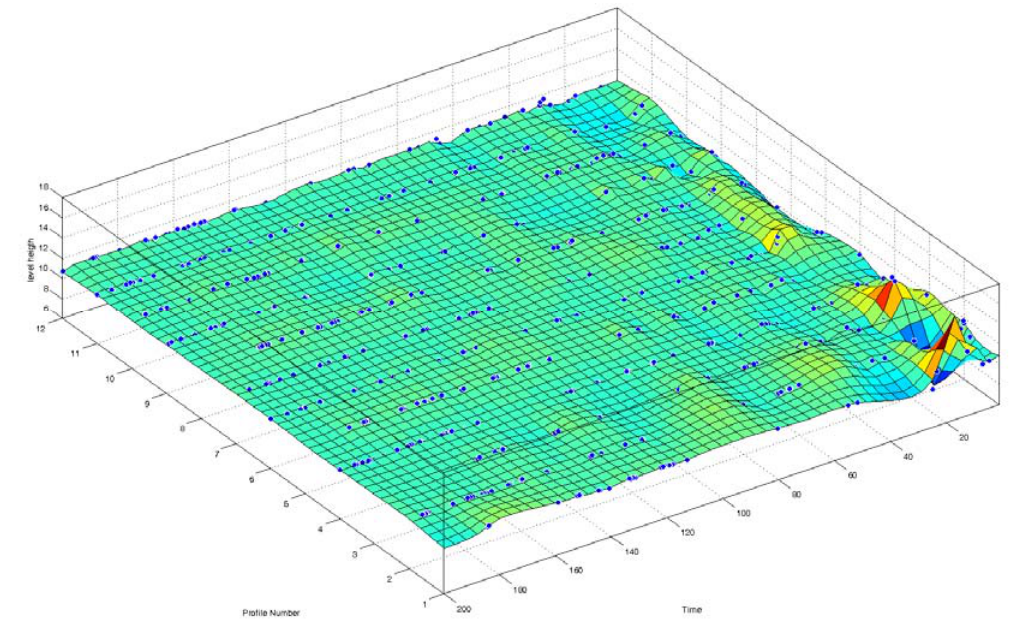
Figure 11: Interpolation of valid measurements (example with sinusoidal wave in longitudinal direction): The red circles mark virtual measurements of horizontal water surface patches